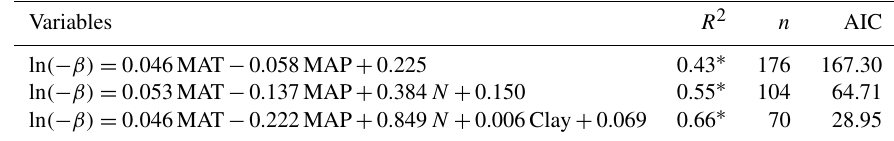
Table 1. Multiple regressions between ln ( − β) and climate and other edaphic factors at global scale. Variables